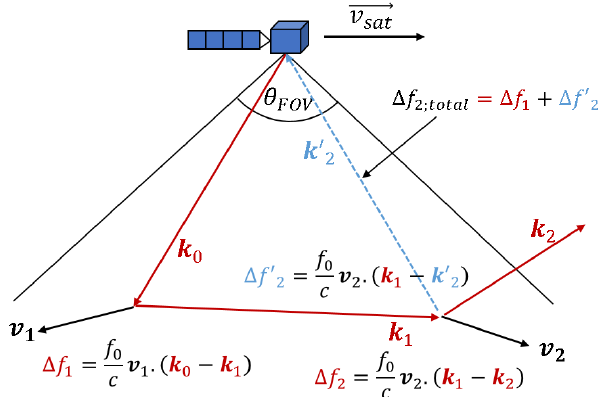
Figure 2. Schematic diagram of the frequency shift consideration along the propagation of photons in scattering medium in the frame- work of the locate estimate